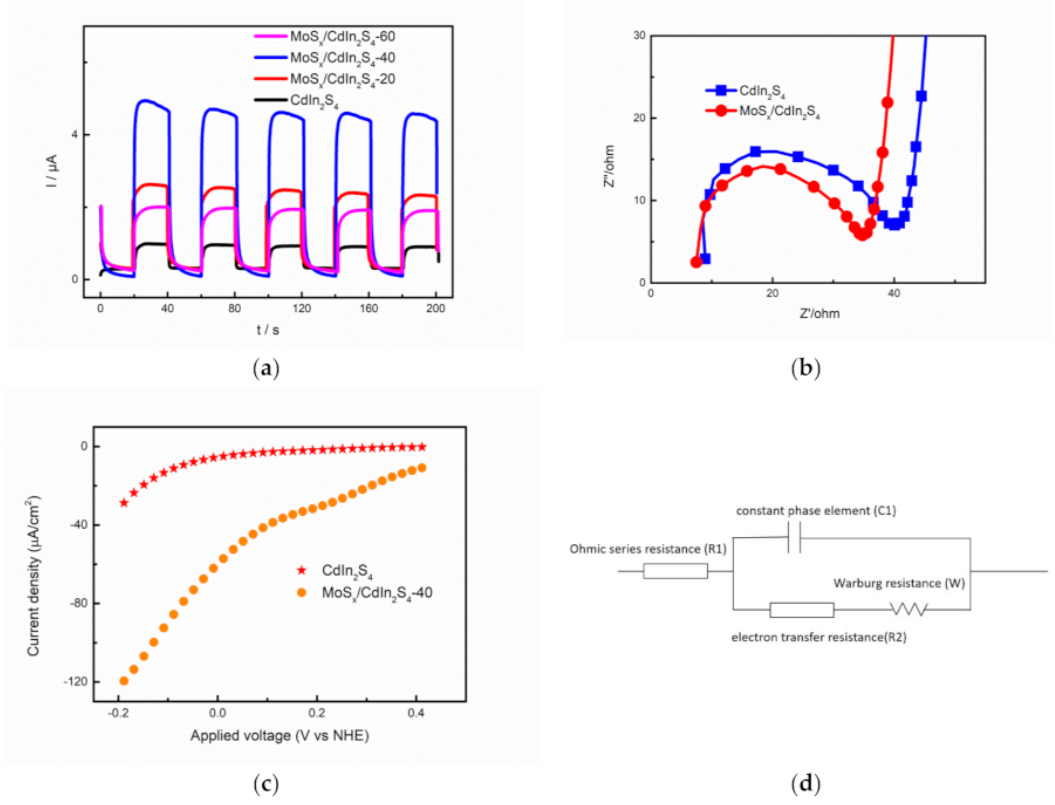
Figure 9. Transient photocurrent responses ( a ) of CdIn 2 S 4 and MoS x / CdIn 2 S 4 ; Electrochemical Impedance Spectroscopy (EIS) Nyquist ( d ) and Linear sweep voltammograms (LSV) ( c ) plots of CdIn 2 S 4 and MoS x / CdIn 2 S 4 ; the circuit model ( d ) in the EIS Nyquist